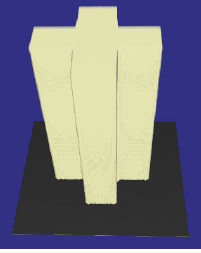
Figure 7. Three-dimensional lithography profiles of a cross-shaped mask with perpendicular incidence using the binary threshold approach, with light intensity obtained by using waveguide method. ( a ) Simulation result; ( b ) experimental result: exposure time = 250 s, development time = 12 min. The first step PEB condition was 65 ◦ C/12 min and the second step PEB condition was 95 ◦ C/40 min.